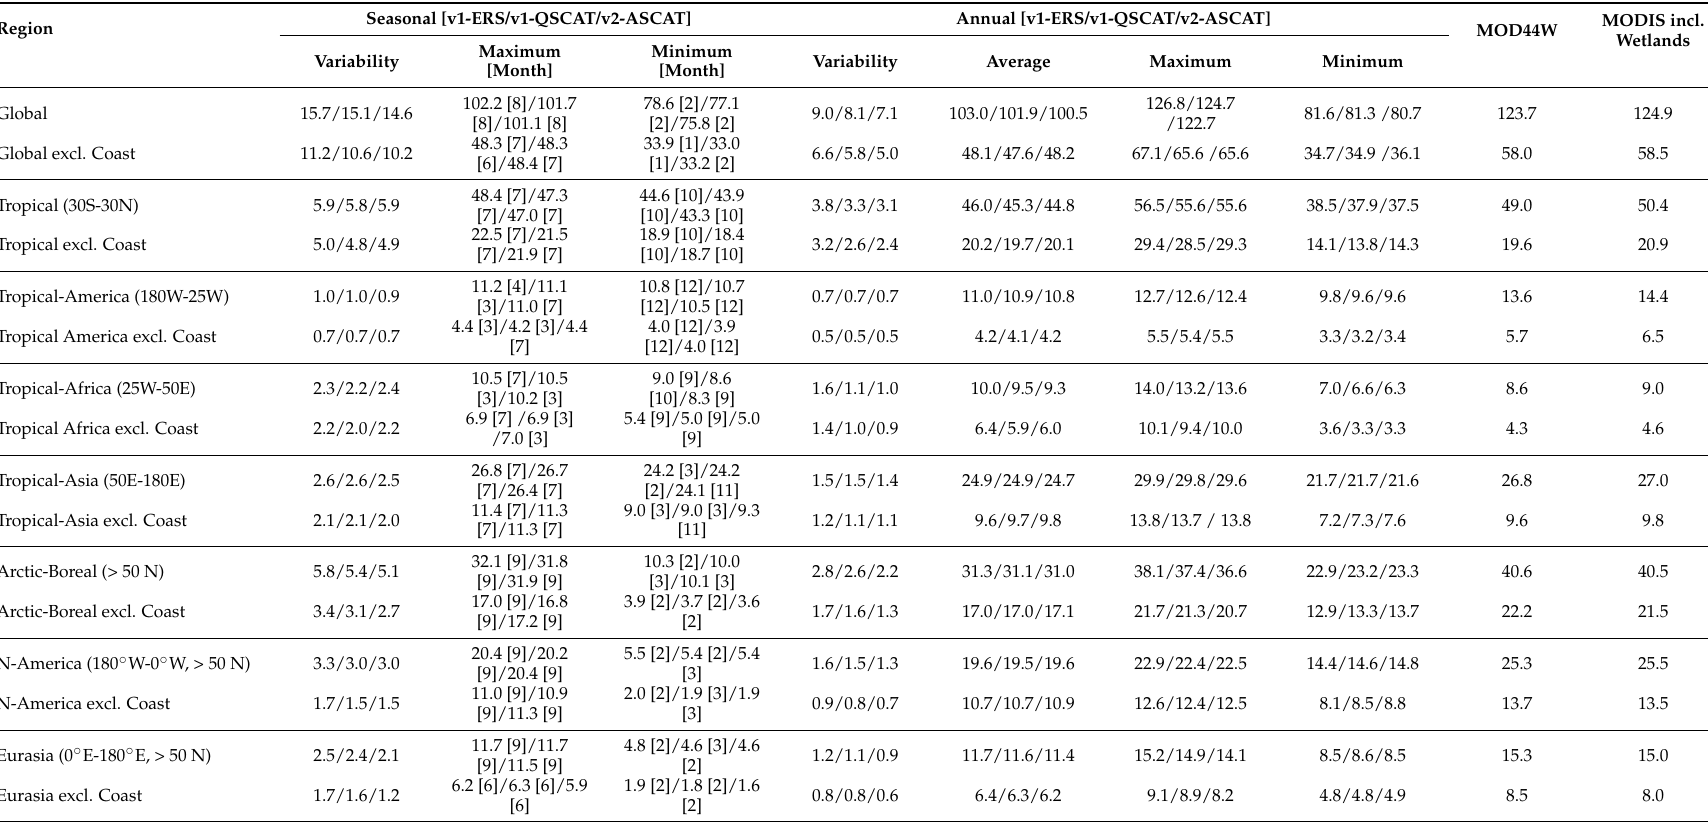
Table 3. Average seasonal maximum and minimum (including month of occurrence), and annual mean, maximum and minimum fractional water (FW) extents (km 2 ˆ 10 5 ) from SWAMPS over the global and regional domains as generated from v1-ERS (1992–2000), v1-QSCAT (2000–2008) and v2-ASCAT (2009–2012) monthly means. Seasonal and annual variability in inundation extents are expressed as the standard deviation of the snow-screened seasonal climatologies and annual means. The FW extents from static measures of FW from the MOD44W and MODIS including wetlands products are shown for